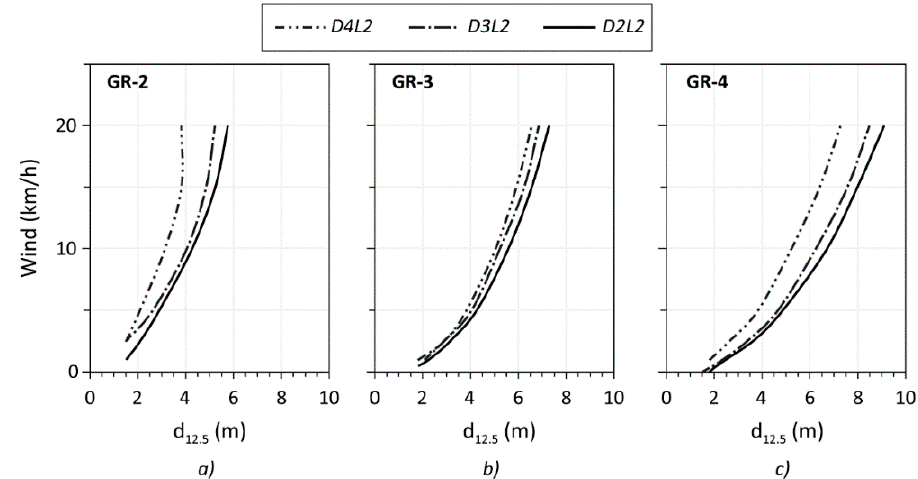
Figure 8. Safe separation distances as a function of wind speed at low MC of live fuel (L2) and variable MC of dead fuel (D2, D3, D4) for each fuel model of GR category: ( a ) GR-2, ( b ) GR-3, ( c ) GR-4.